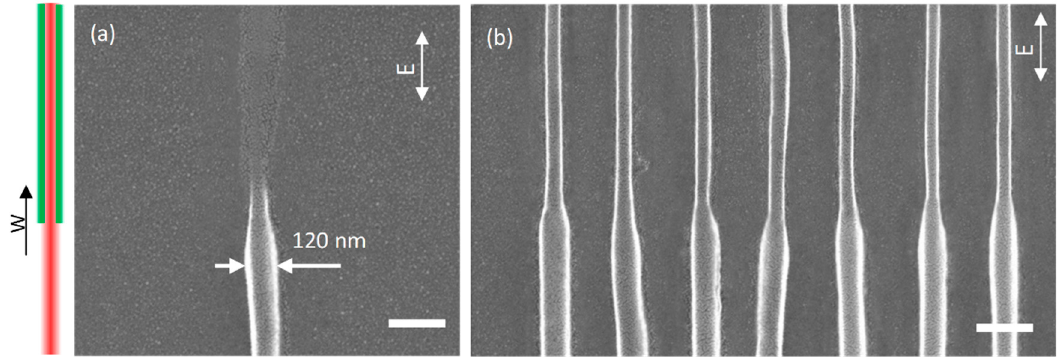
Figure 7. Scanning electron micrograph of STED direct laser writing nanowires. ( a ) 11 mW two-photon excitation power, 30 mW depletion power. ( b ) A series of STED-direct laser writing (DLW) nanowires with 45 nm width. W: scanning direction, E: laser polarization direction, scale bar 200 nm.